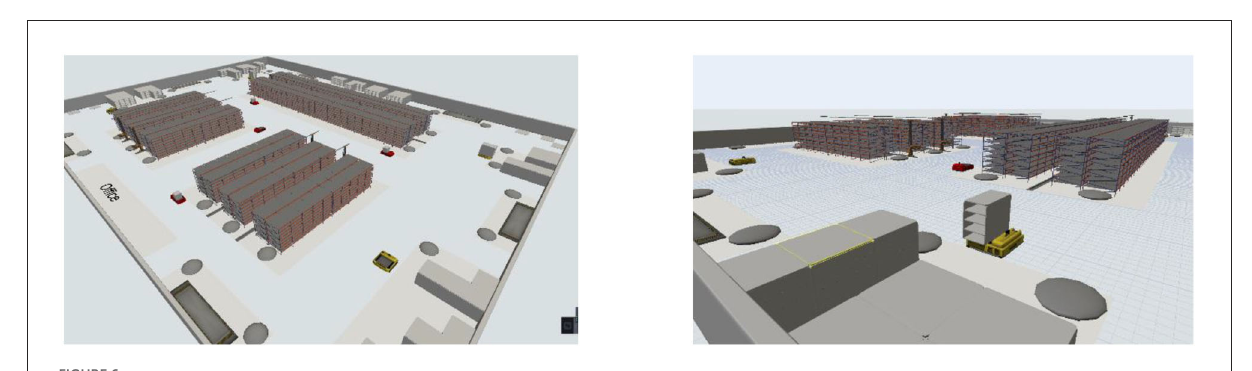
FIGURE5 Warehouse layout.